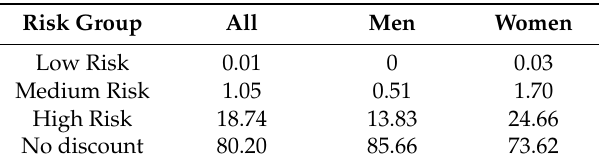
Table 6. Percentage of drivers in each risk